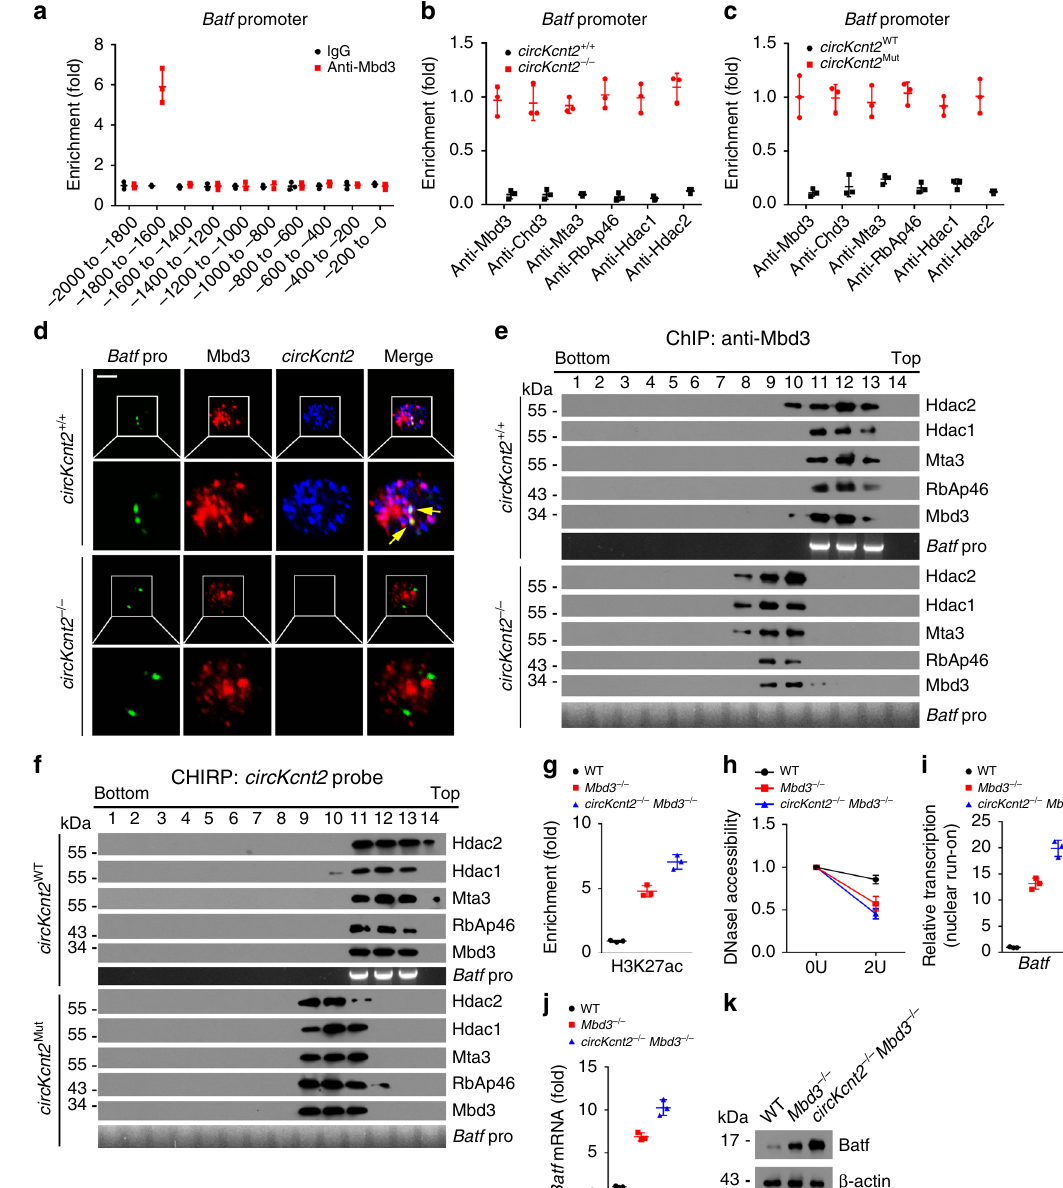
Fig. 5 CircKcnt2 recruits the NuRD complex onto Batf promoter to suppress its expression. a Analysis of Mbd3 enrichment on Batf promoter by ChIP assay. ILC3s was isolated from DSS-treated WT mice. n = 3 independent samples. b Enrichment analysis of NuRD complex component proteins on Batf promoter in circKcnt2 + / + and circKcnt2 − / − ILC3s after DSS treatment. n = 3 independent samples. c ChIP assay for enrichment of NuRD complex component proteins on Batf promoter in circKcnt2 WT and circKcnt2 Mut ILC3s from DSS-treated mice. n = 3 independent samples. d FISH assay for analysis of co-localization between Mbd3 and Batf promoter in circKcnt2 + / + and circKcnt2 − / − ILC3s from DSS-treated mice. Green, Batf promoter; red, Mbd3; blue, circKcnt2 . Scale bar, 5 μ m. e LPLs isolated from DSS-treated circKcnt2 + / + and circKcnt2 − / − mice were used for ChIP assay with anti-Mbd3. Eluents were subjected to sucrose gradient ultracentrifugation, followed by western blotting and PCR analysis. f LPLs were isolated from DSS-treated circKcnt2 WT and circKcnt2 Mut mice and used for CHIRP assay using biotin-labeled circKcnt2 probes. g ChIP assay for enrichment analysis of H3K27ac on Batf promoter in Mbd3 − / − , circKcnt2 − / − Mbd3 − / − , or WT control ILC3s. n = 3 independent samples. h DNaseI accessibility assay for Batf promoter accessibility in Mbd3 − / − , circKcnt2 − / − Mbd3 − / − , or WT control ILC3s. n = 3 independent samples. i ILC3s from DSS-treated Mbd3 − / − , circKcnt2 − / − Mbd3 − / − , or WT control mice were subjected to nuclear run-on assay, followed by RT-PCR analysis of Batf . n = 3 independent samples. j , k Analysis of Batf expression by qRT-PCR and western blotting in Mbd3 − / − , circKcnt2 − / − Mbd3 − / − , or WT control ILC3s. n = 3 independent samples. Data were analyzed by an unpaired Student ’ s t -test and shown as means± SD. Data are representative of at least three independent experiments. Source data are provided as a Source Data fi